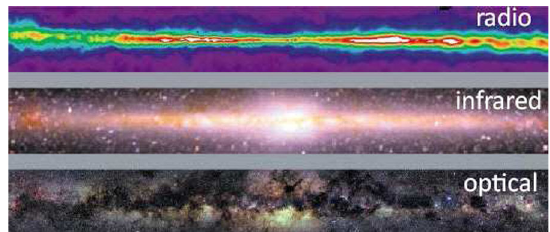
FIG. 1. The Milky Way observed at radio, infrared, and optical. Following open-ended questions were asked: These images are each of the same part of the Milky Way made from observations at radio, infrared and optical wavelengths. Why do you think the colors in the radio image look much different from the ones in the infrared or optical images?; Why do you think there is a bright horizontal band in the infrared image where the optical image mostly looks dark?; and, Why do you think the structures in the three images are